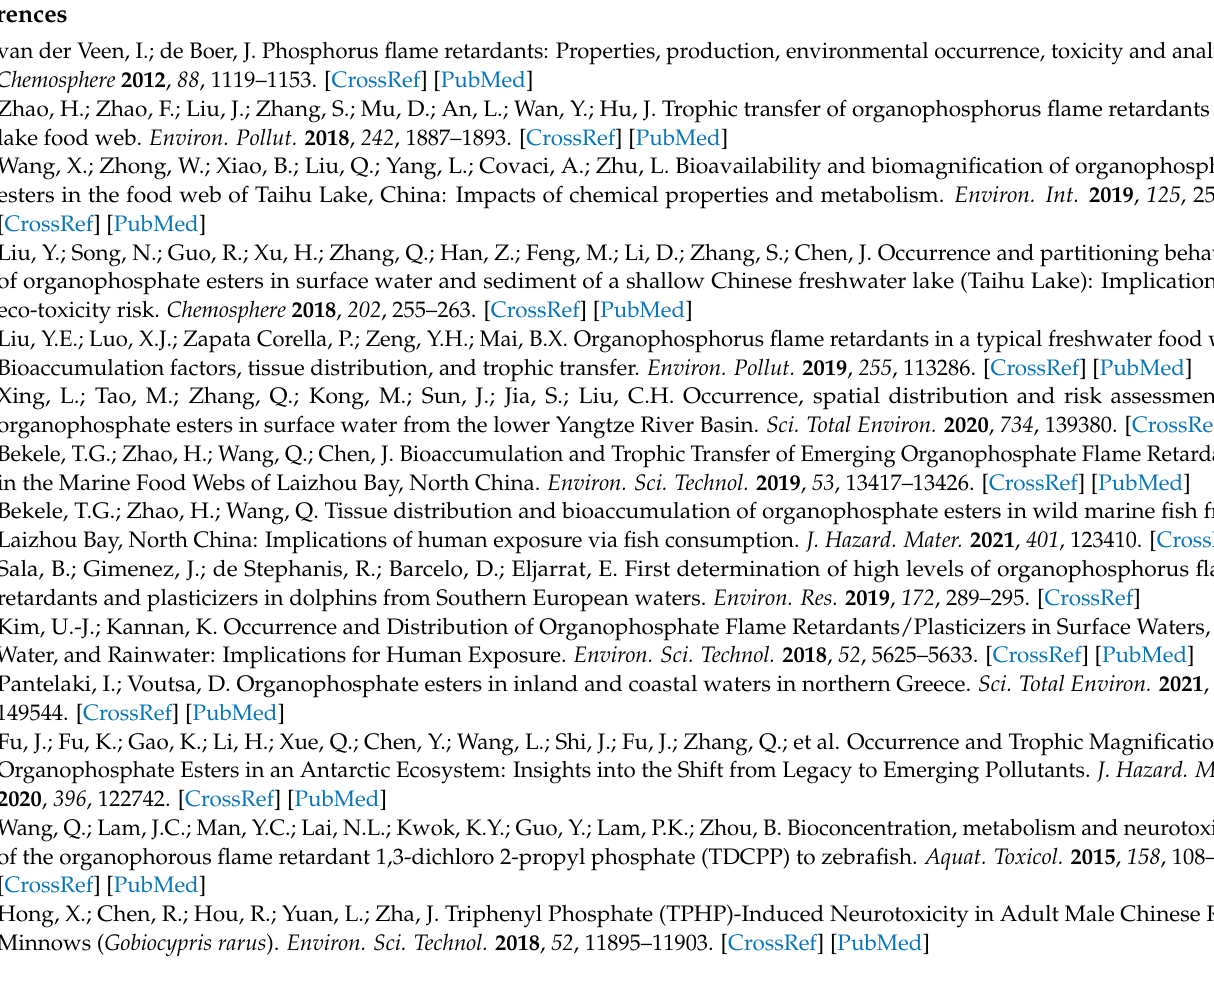
S5. Chemical and physical properties of OPEs; Figure S1. OPEs ((a) TCEP, (b) TDCPP, (c) TBOEP, (d) TPHP) in Scenedesmus obliquus (SO) (ng/g dw). Solid points represent the high concentration group (100 µ g/L) and hollow points represent the low concentration group (20 µ g/L). The actual exposure concentration has been shown in the legend. The values were the means ± SD of three replicates; Figure S2. OPEs ((a) TCEP, (b) TDCPP, (c) TBOEP, (d) TPHP) in exposure solution during the waterborne exposure experiment ( µ g/L). Black lines and points represent the low concentration group (20 µ g/L) and red lines and points represent the high concentration group (20 µ g/L). The values were the means ± SD of three replicates; Figure S3. Concentration of OPEs in the solution during the dietary experiment ( µ g/L). (a) OPEs in solution at low exposure concentration (20 µ g/L). (b) OPEs in solution at high exposure concentration (100 µ g/L). The values were the means ± SD of three replicates; Figure S4. Structure of four OPEs ((a) TCEP, (b) TDCPP, (c) TBOEP, (d) TPHP). References [3,30,45] are cited in Supplementary